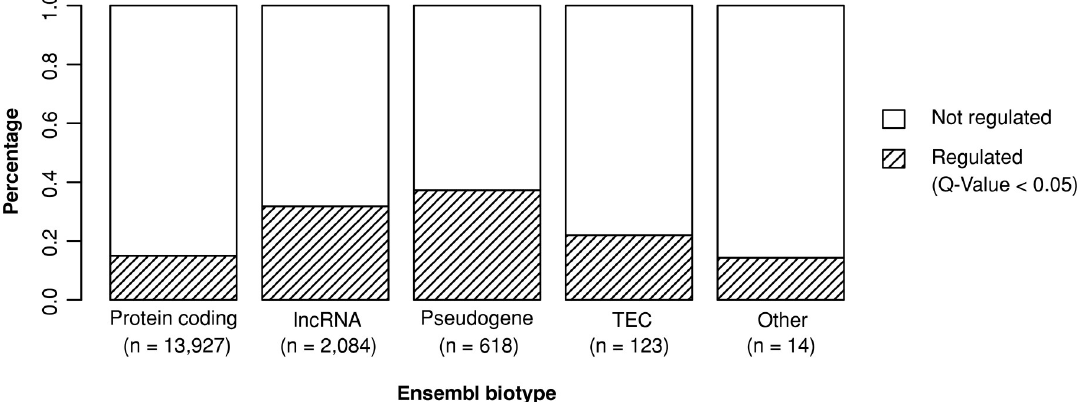
Fig 1. Distribution of Ensembl biotypes across all analyzed genes. 16,766 expressed autosomal genes in retinal tissue were characterized with regard to their Ensembl biotype [16]. The Q-Value threshold 0.05 was chosen to define significance for the eQTL analysis. For this graph, all biotypes including the term “Pseudogene” were compiled into one section. lncRNA = long non-coding RNA; TEC = to be experimentally confirmed.